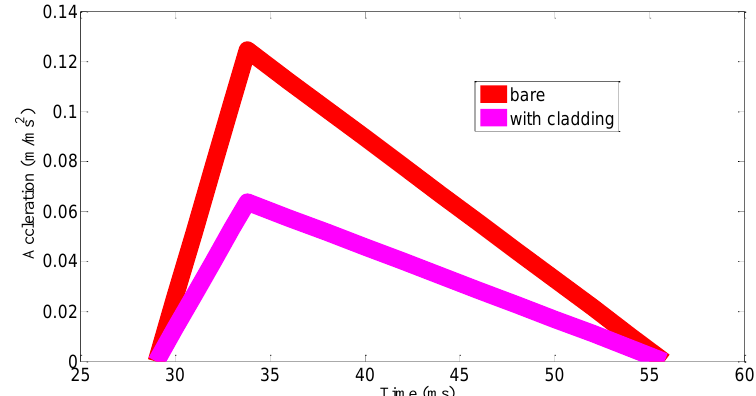
(c): Response of blast load on rear wall along acceleration with and without Cladding material. Fig. 15. Response of the SDOF with cladding material subjected to blast load on rear